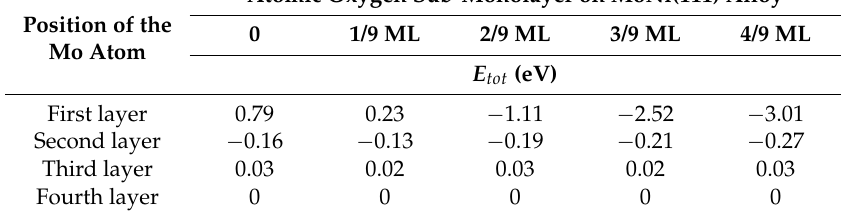
Table 1. Calculated segregation energies for MoNi alloy configurations with different adsorbed atomic oxygen coverage. The reported segregation energies of molybdenum in O-MoNi(111) systems are calculated by considering the most energetically stable adsorbed oxygen